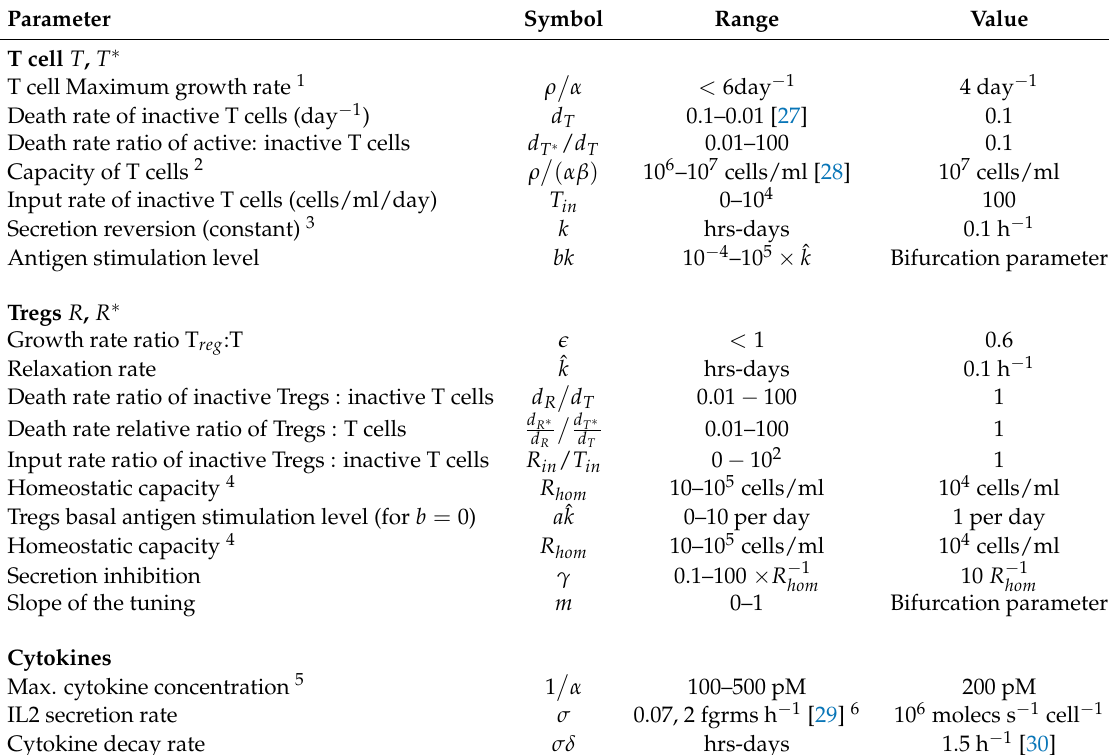
Table 1. Values of parameters for our model of T cells and Tregs, adapted from [13,23].